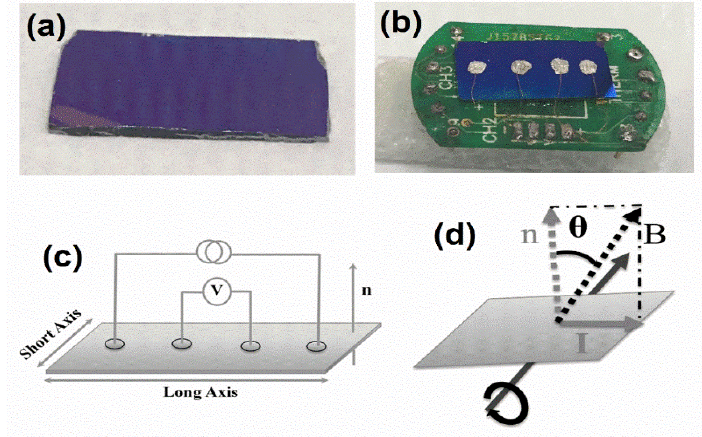
Figure 1. (a) Sample image of the grown film; (b) stage for the MR measurement; (c) schematic for the Figure 1. ( a ) Sample image of the grown film; ( b ) stage for the MR measurement; ( c ) schematic for the 4-probe measurement and (d) angular MR measurement. 4-probe measurement and ( d ) angular MR